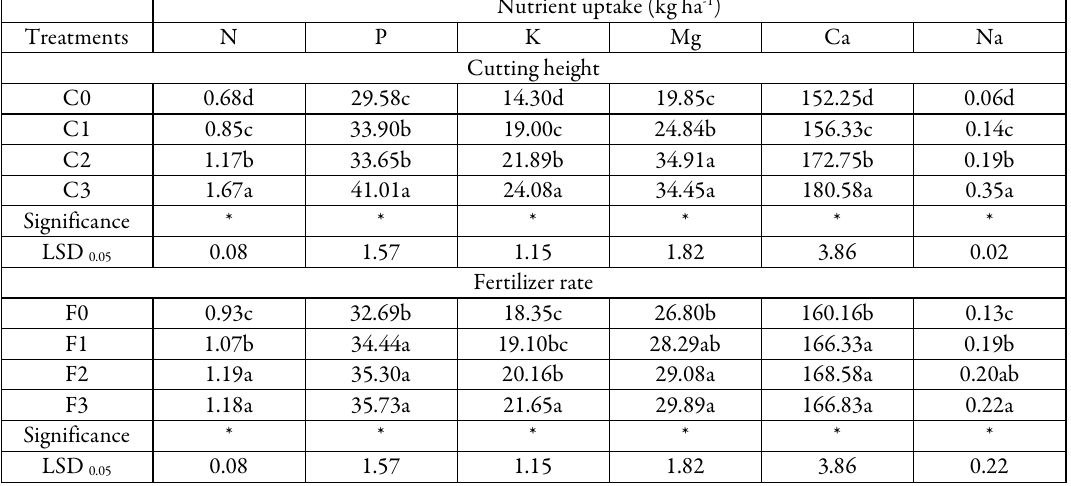
Nutrient uptake (kg ha -1 )